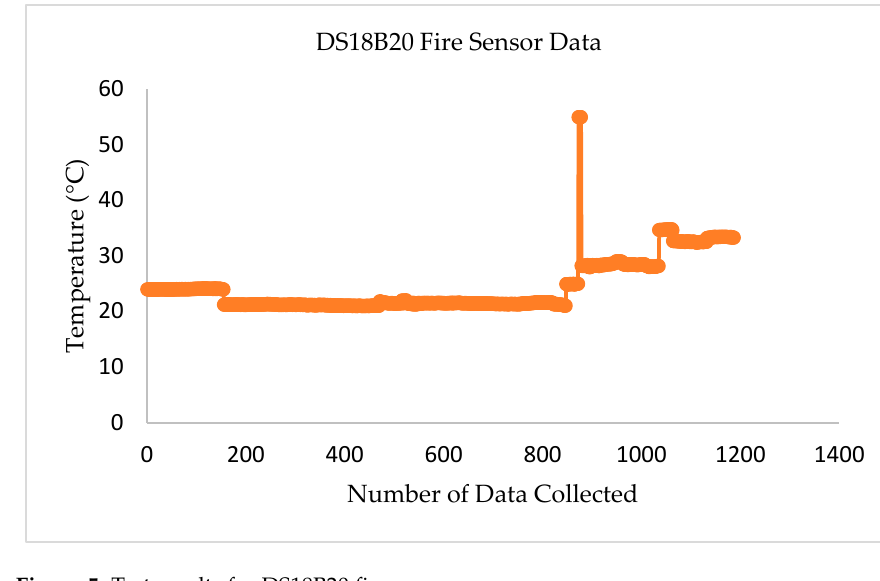
Figure 5. Test results for DS18B20 fire sensor.